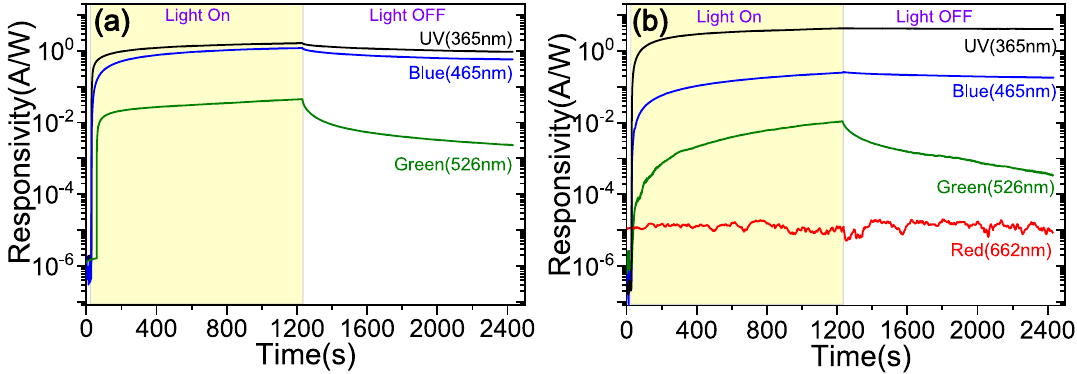
Figure 4. Transient response of responsivity (photocurrent generated per unit of applied light intensity) of the ZTO TFTs for the sample ( a ) 33ZTO and ( b ) 50ZTO measured at different photoexcitation energy: UV (at 365 nm); blue (at 465 nm); green (at 526 nm); red (at 662 nm).